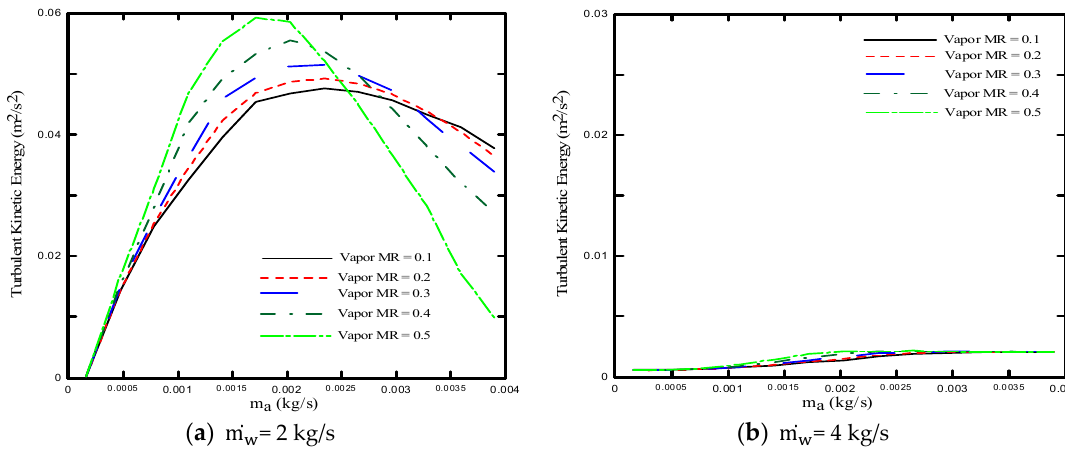
Figure 8. Effect of air and vapor mass flow rates on the turbulent intensity in the tube upper region. Appl. Sci. 2020 , 10 , x FOR PEER REVIEW